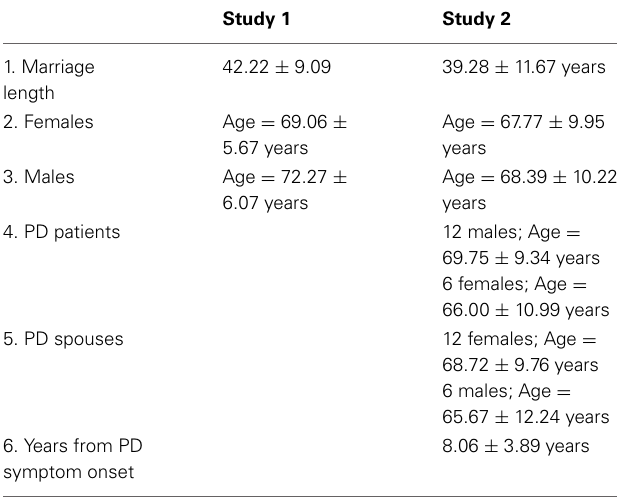
Table 1 | Demographic information for the Study 1 and 2